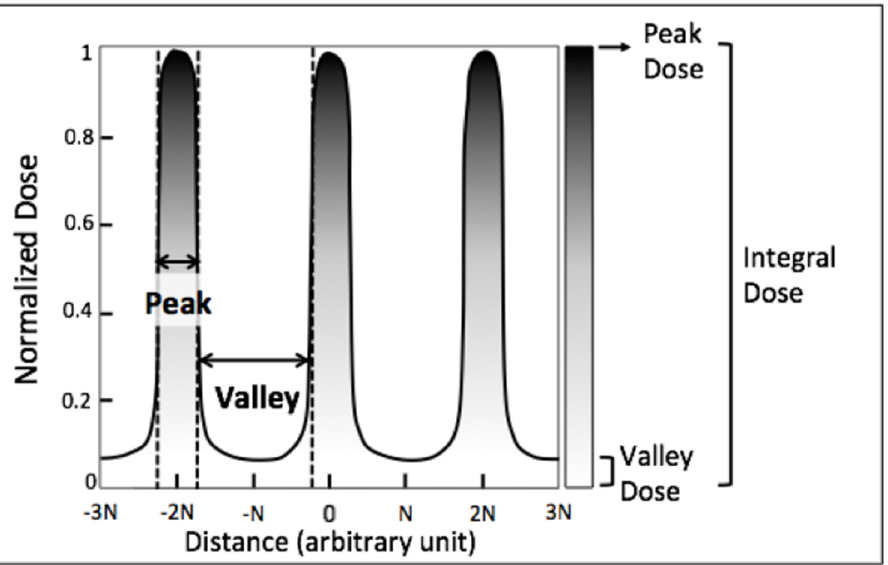
Figure 1. The schematic beam profile of microplanar radiotherapy (MRT). MRT delivers hundreds of Gys in spatially fractionated quasi-parallel micrometer beams. The beam profile consists of high-dose X-ray irradiation beams (peaks), separated by wider non-irradiated regions (valleys).